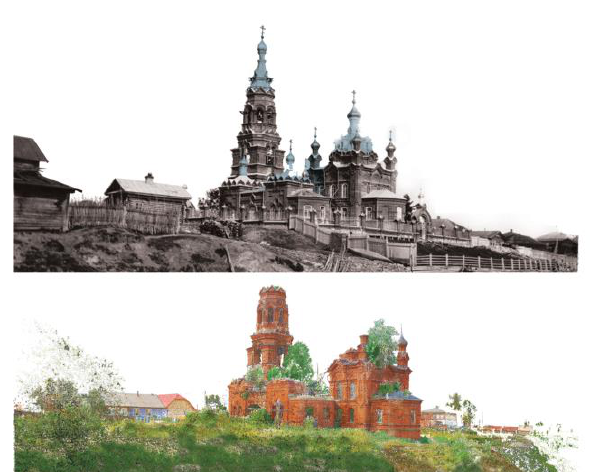
Figure 1. The Church of the Annunciation in Pokcha: a comparison between an historical photo and the point cloud from the survey of 2018 summer school.